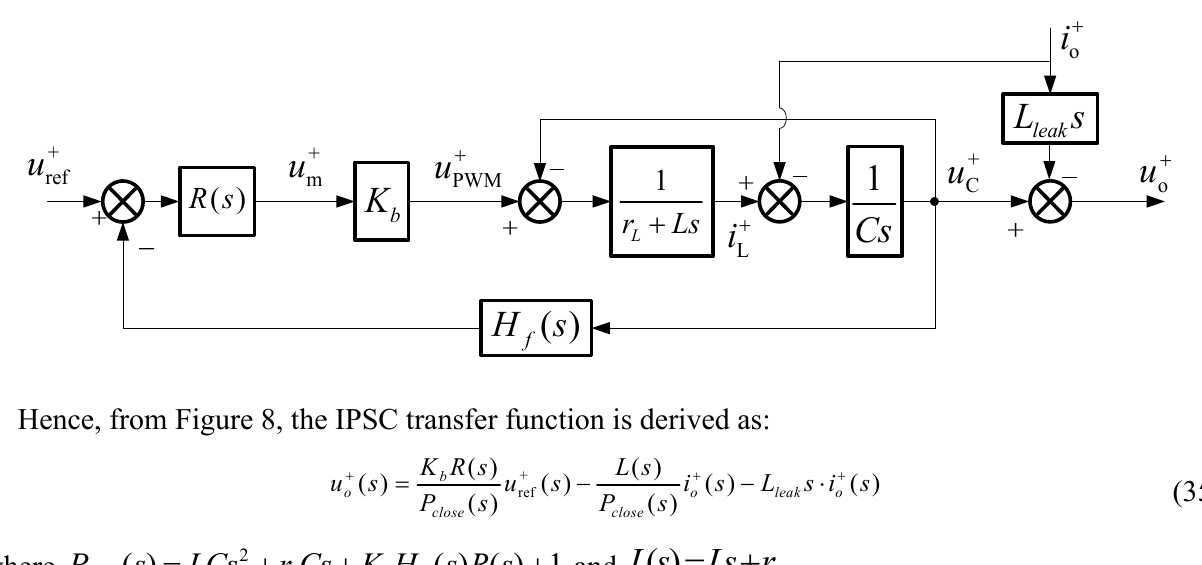
Figure 8. IPSC transfer function diagram for three-phase inverters with instantaneous feedback